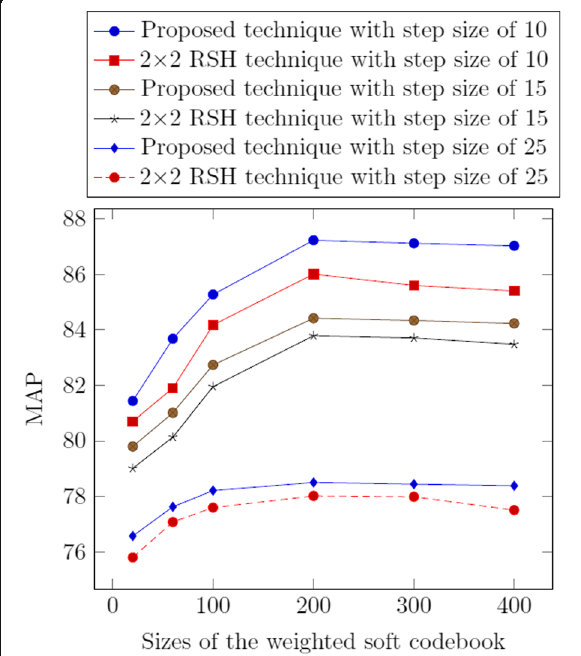
Fig. 7 Effect on the MAP performance by varying weighted soft codebook sizes on the image benchmark of the